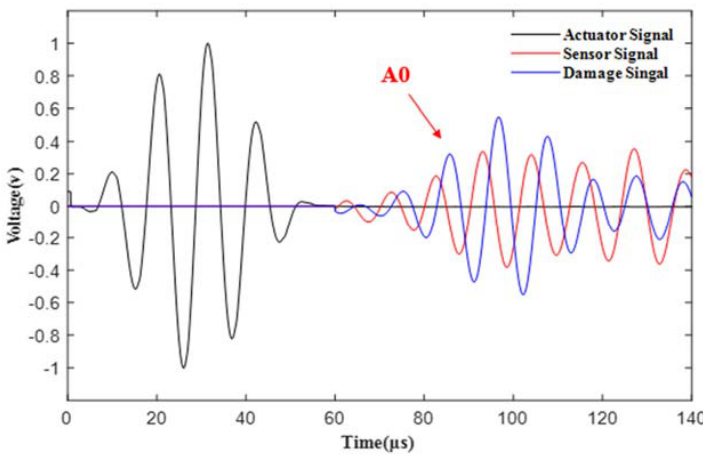
Figure 13. Comparison of health signal of sensor pair 2–5 and received signal of corrosion damage.